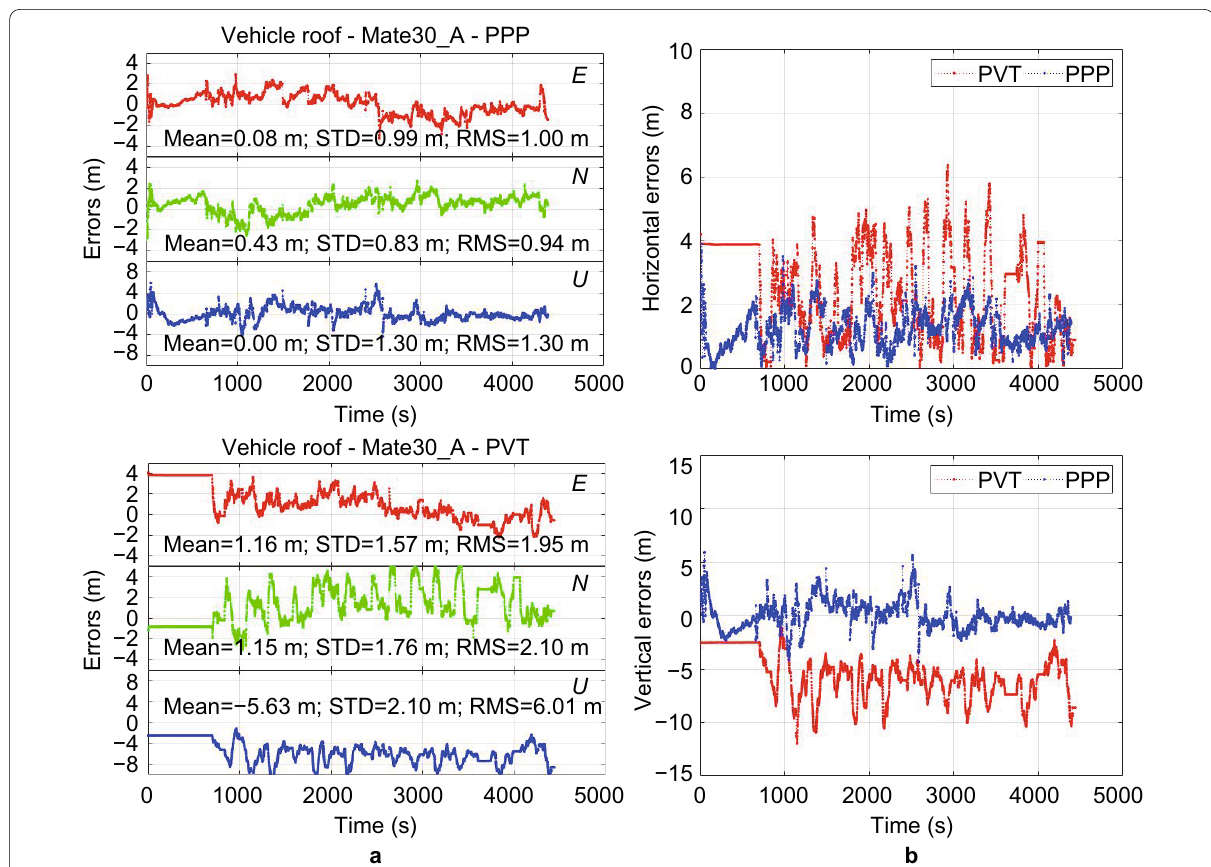
Fig. 10 The time series of the positioning errors of PPP and PVT results in a the E , N , and U components and b the horizontal and vertical directions for the Mate30_A smartphone in the vehicle-roof mode